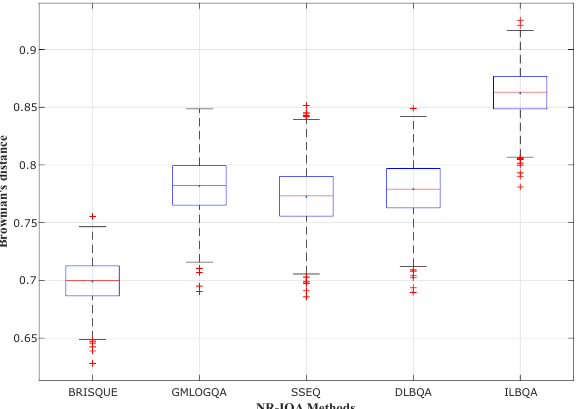
Figure 5. Performance comparison for different NR-IQA methods trained on LIVE.